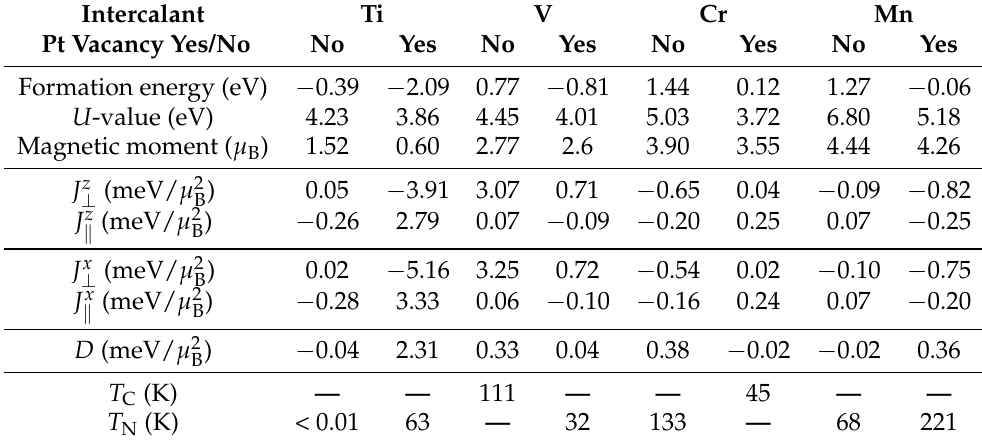
Table 1. Summary of the results for the intercalated PtSe 2 with and without vacancies. Results for structures with vacancies are in the columns marked with (Pt V